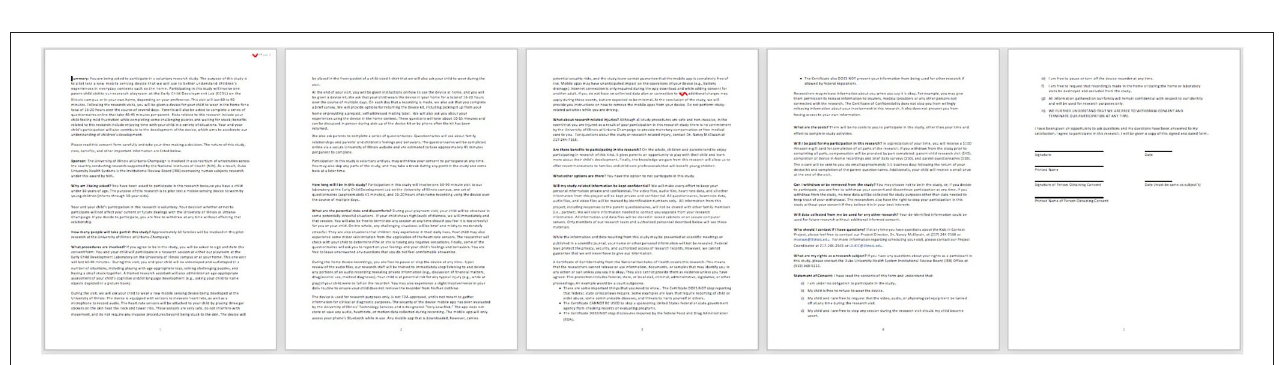
FIGURE 4 | Rewritten version of consent form by research team that includes all required elements of informed consent.